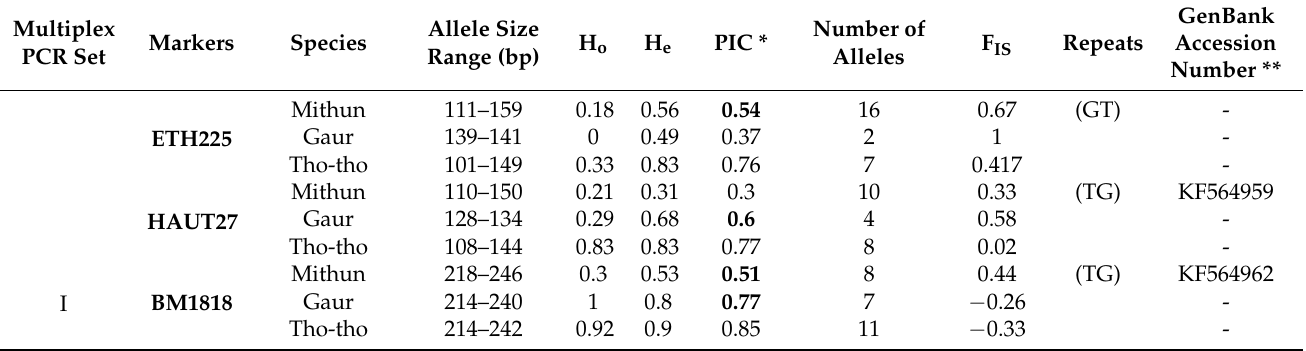
Table 1. Bovine microsatellite markers tested for diversity analysis in Indian Mithuns, wild gaur, and Tho-tho